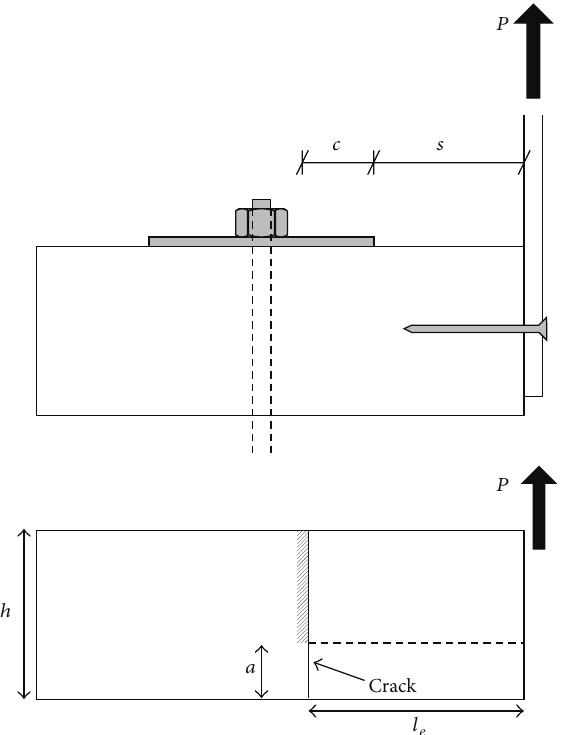
Figure 8: Geometry, boundary conditions, and loading conditions used in Serrano et al. [17] and in Caprolu et al. [18] for a vertical